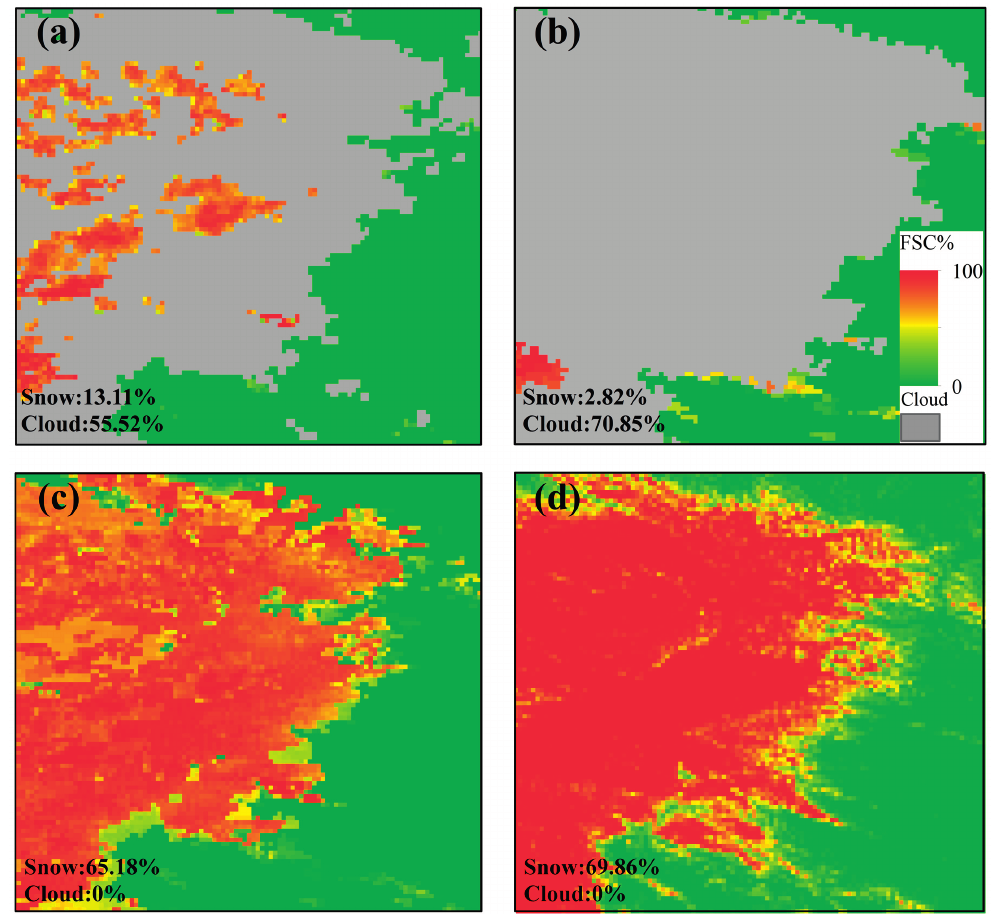
Figure 6. Fractional snow cover map for 16 January 2014. ( a ) MOD10A1; ( b ) MYD10A1; ( c ) final composite snow map; ( d ) OLI snow map.